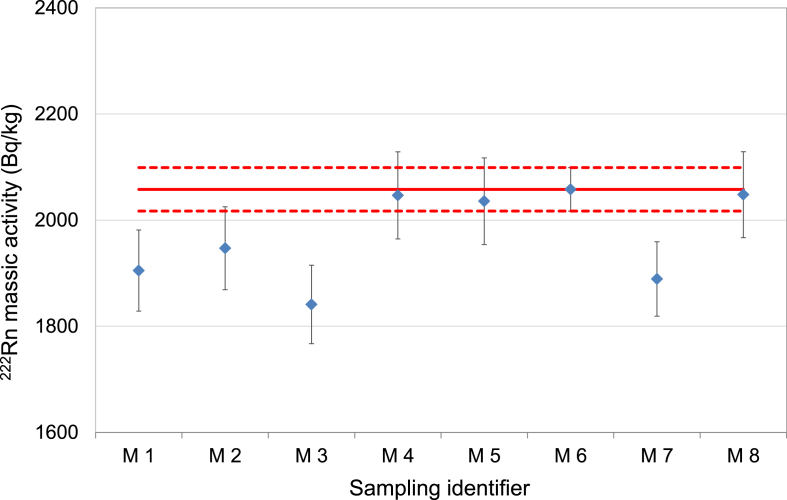
Comparison of different subsampling and transfer approaches to the direct GS measurement (M1: Intense pouring; M2: Careful pouring; M3: Gas tight syringe with needle 1; M4: Gas tight syringe with needle 2; M5: Gas tight syringe with tube and needle; M6: Gama-ray spectrometry; M7: Pipetting with suction; M8: Pipette immersion). The solid red line indicates the 222Rn massic activity from the direct measurements (M6) and the dashed red lines represent its combined standard uncertainty. (For interpretation of the references to colour in this figure legend, the reader is referred to the Web version of this article.)